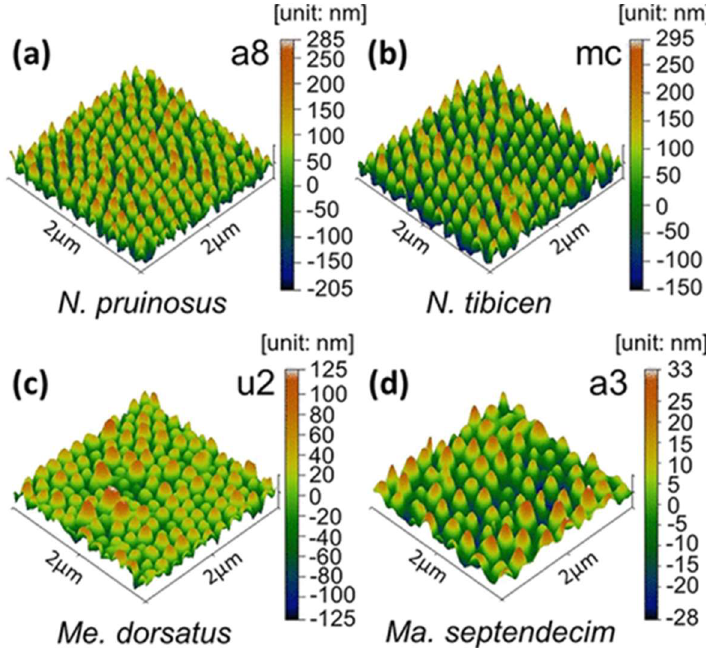
Figure 3. Representative scans of various species of cicada depicting the nanopillar structure, in- cluding ( a ) N. pruinosus, ( b ) N. tibicen, ( c ) Me. Dorsatus, ( d ) Ma. Septendecim. Reprinted with per- mission from Ref. [73] Copyright 2017 American Chemical Society.